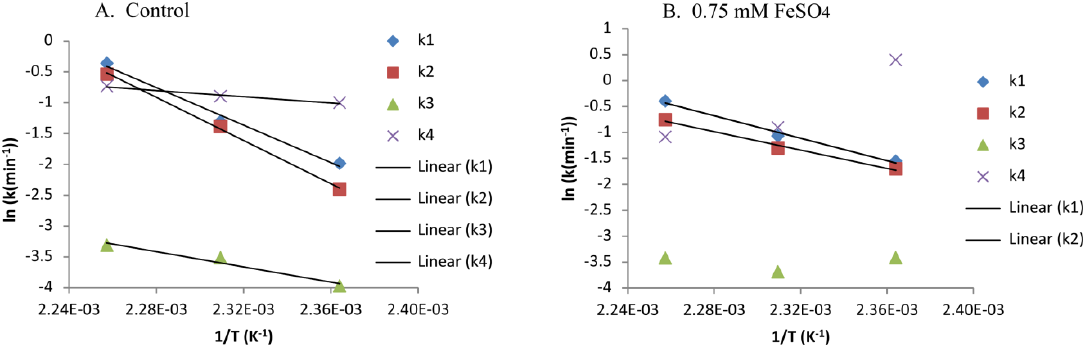
Figure 4. Arrhenius plots for control (acid alone) and 0.75 mM FeSO 4 cocatalyst pretreatment from Table 2. The analysis is presented for ( A ) the control, and ( B ) 0.75 mM FeSO 4 cocatalyst pretreatments.